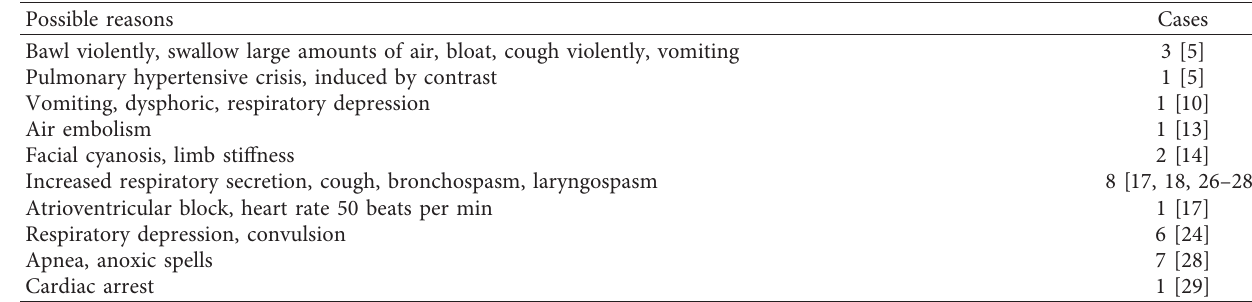
Table 2: Reasons for unexpected endotracheal intubation.